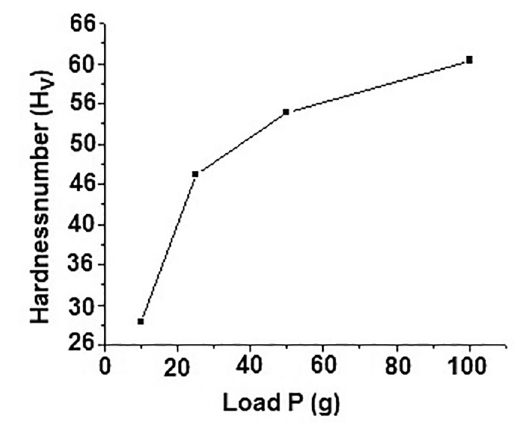
Figure 7: Microhardness number VS Load P.